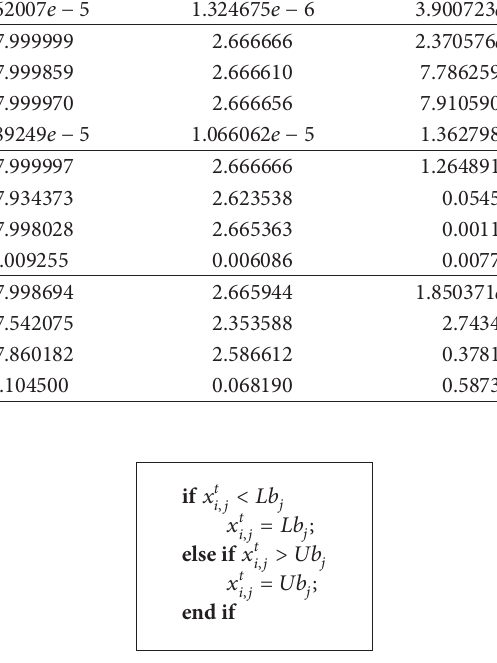
Algorithm 1: Cross-border processing function.